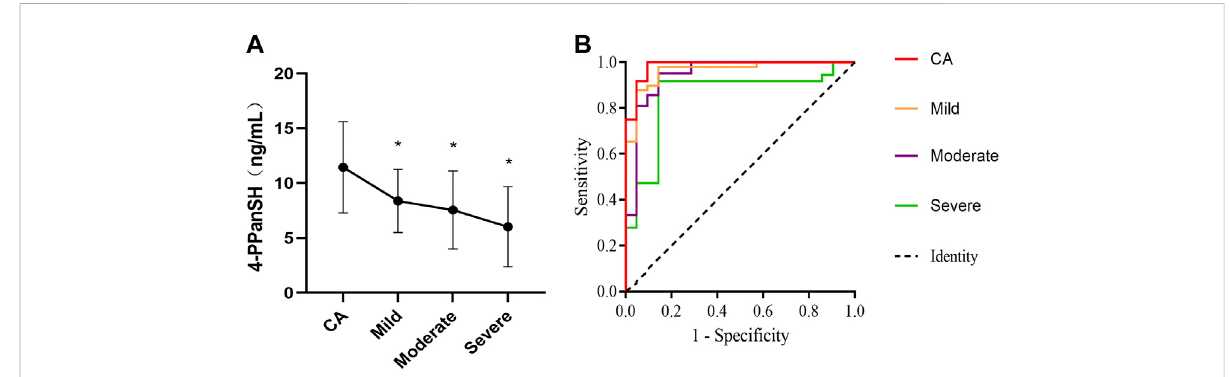
FIGURE 3 4-PPanSHwasrelatedtoCHDpatientswithdifferentdegreesofcoronaryocclusion. (A) 4-PPanSHcontentgraduallydecreasedwithincreased coronary occlusion. (B) 4-PPanSH was associated with the degree of coronary stenosis. *Indicates p < 0.05 compared to the CA group.